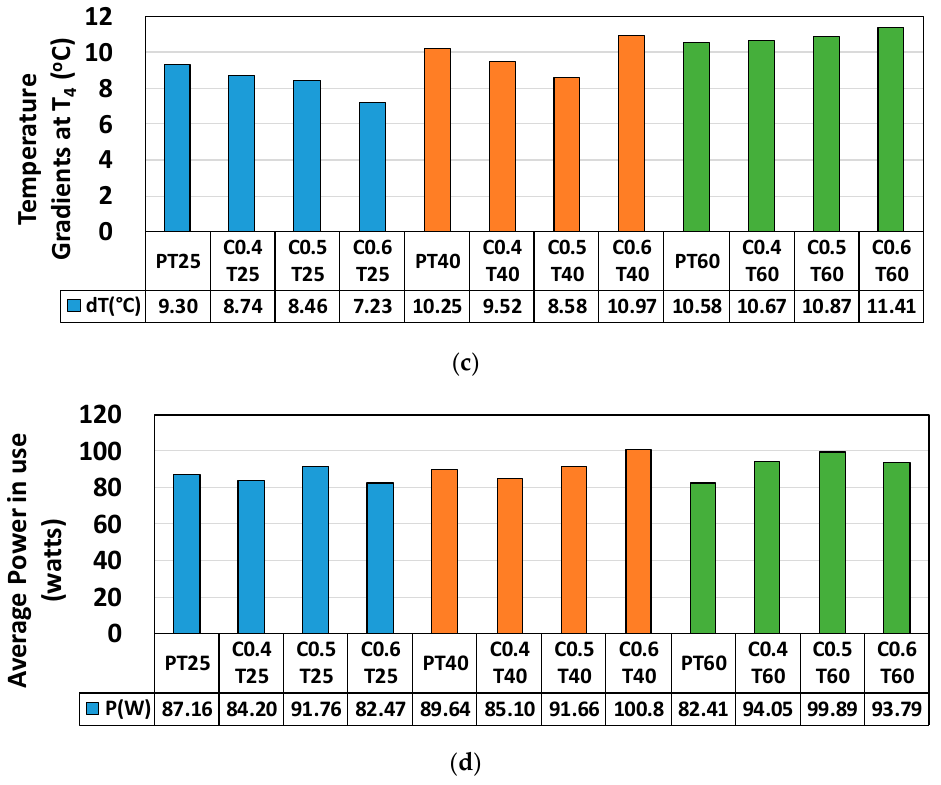
Figure 3. Measured properties: ( a ) thermal conductivity (W/m °C), ( b ) absolute thermal conductivity (W/°C), ( c ) temperature gradient, Δ T = T 0 − T 4 , and ( d ) power (watts) in use for the heating process.